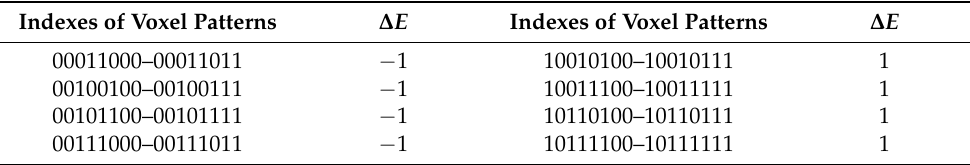
Table 4. Euler number increments of voxel patterns with consecutive